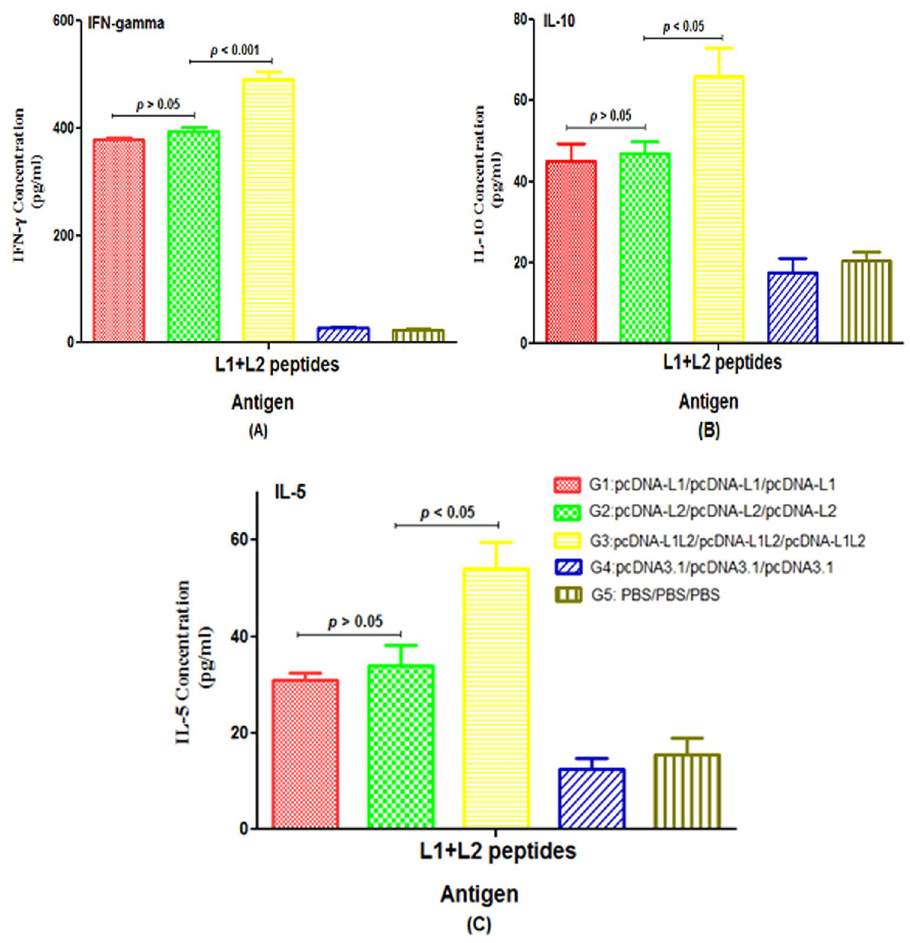
Figure 7. The levels of IFN- γ ( A ), IL-10 (B) and IL-5 ( C ) in vaccinated groups with different formulations: The pooled splenocytes were prepared from three mice in each group (n = 3 per group) and re-stimulated with the mixture of L1 + L2 peptides in vitro . The levels of cytokines were measured in the supernatant with ELISA as mean absorbance at 450 nm ± SD for each sample. All analyses were performed in duplicate for each sample.